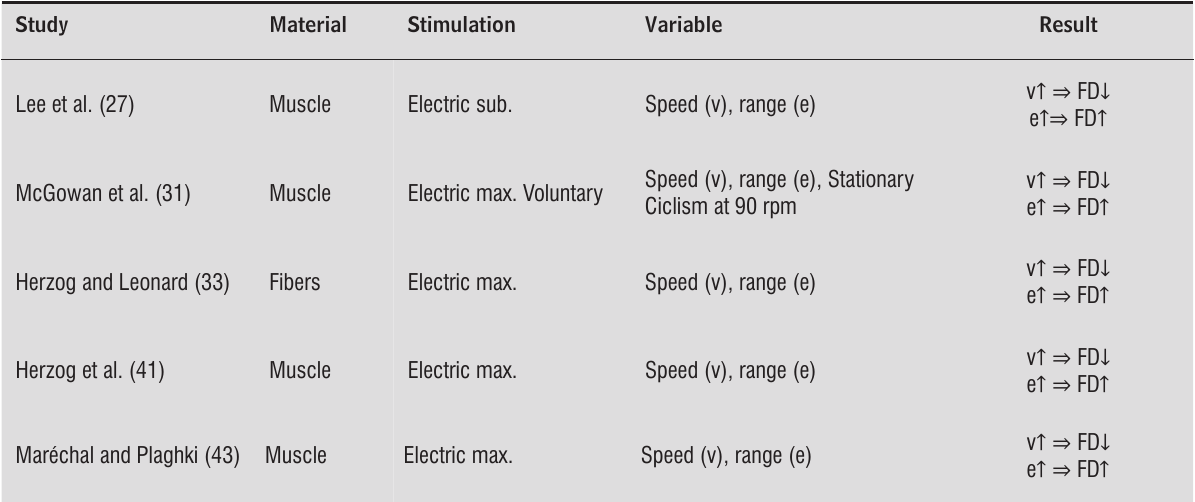
Table 1 - Main characteristics of the studies on FD as regard to type of stimulation, material used and the observed ef- fects considering the characteristics of the shortening